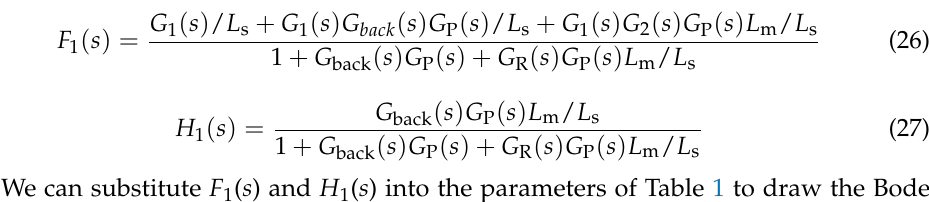
Table 1. DFIG experimental platform-related